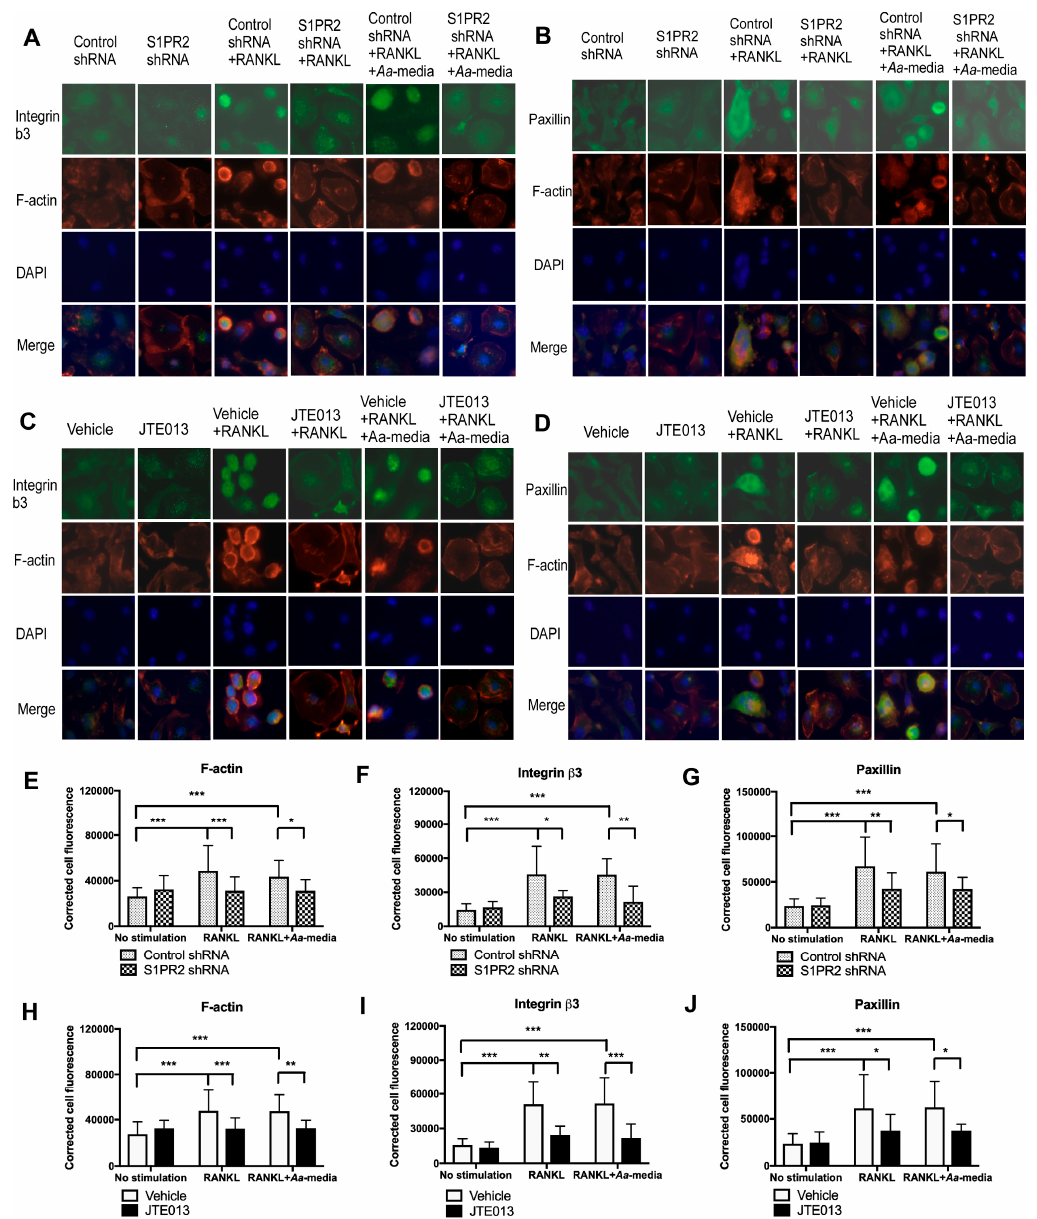
Figure 8. Immunofluorescence staining of integrin β 3, F-actin, and paxillin in BMMs. Murine BMMs were treated with control shRNA/S1PR2 shRNA for one day or treated with vehicle/ JTE013 for 30 min. Then, cells were cultured in media containing M-CSF (50 ng/mL) alone or M-CSF with RANKL (250 ng/mL) for two days. On the third day, the media was changed with or without RANKL and/or JTE013. Some of the cells were co-cultured with both RANKL and Aa -stimulated media ( Aa- media, 200 µL/mL) for another day. ( A ) and ( C ) show representative images of integrin β 3, F-actin, and DAPI staining in BMMs (four to six cells per image). ( B ) and ( D ) show representative images of paxillin, F- actin, and DAPI staining in BMMs (four to six cells per image). ( E ) and ( H ) show cell fluorescence intensity of F-actin. ( F ) and ( I ) show cell fluorescence intensity of integrin β 3. ( G ) and ( J ) show cell fluorescence intensity of paxillin. (* p < 0.05, ** p < 0.01, *** p < 0.001).